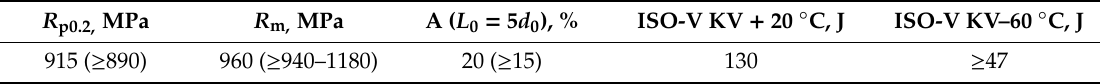
Table 2. Mechanical properties of all-weld metal for the solid wire Boehler X 90-IG in untreated condition, as welded with shielding gas Ar + 15–25% CO 2 (ISO 14175:2008–M21), reproduced from [12], with permission from voestalpine Böhler Welding Austria GmbH,